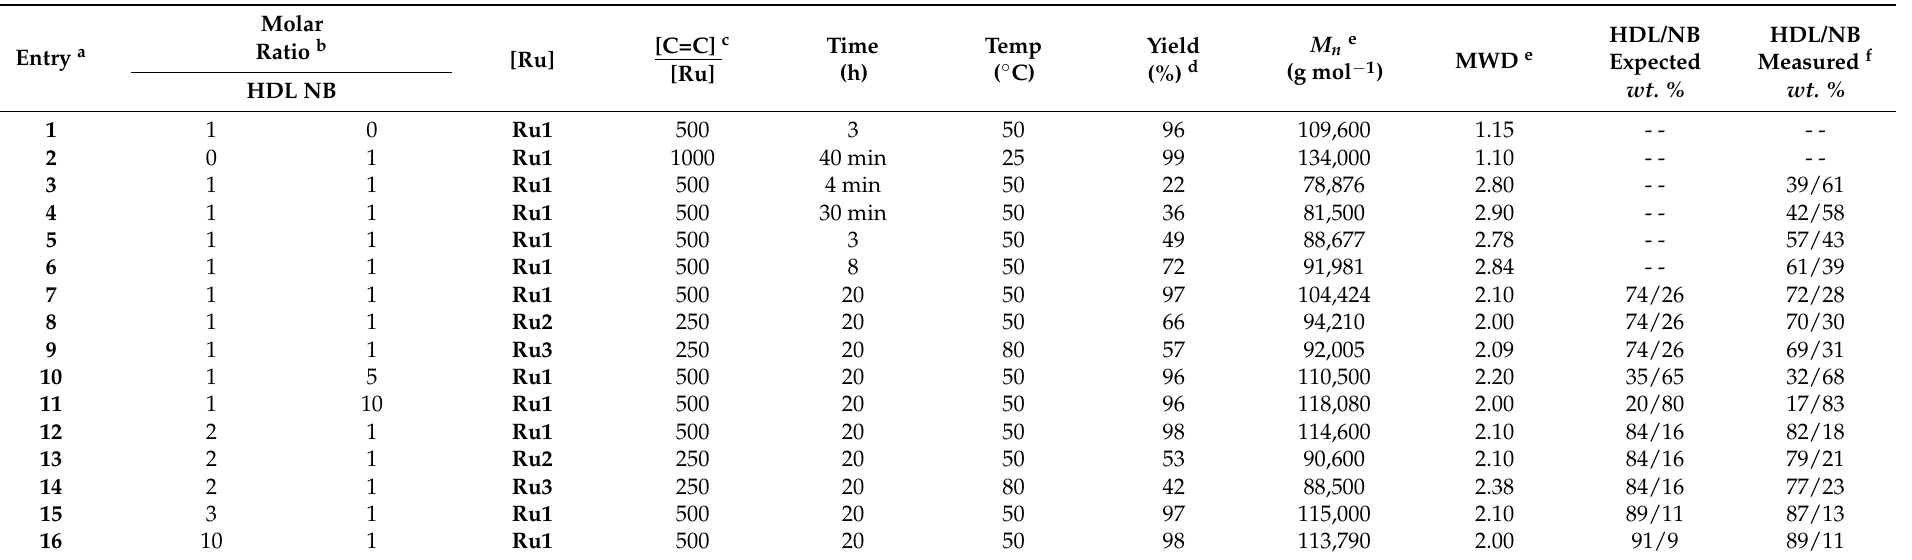
Table 1. Copolymerization via ROMP of w -6-hexadecenlactone (HDL) with norbornene (NB) using Ru1–3